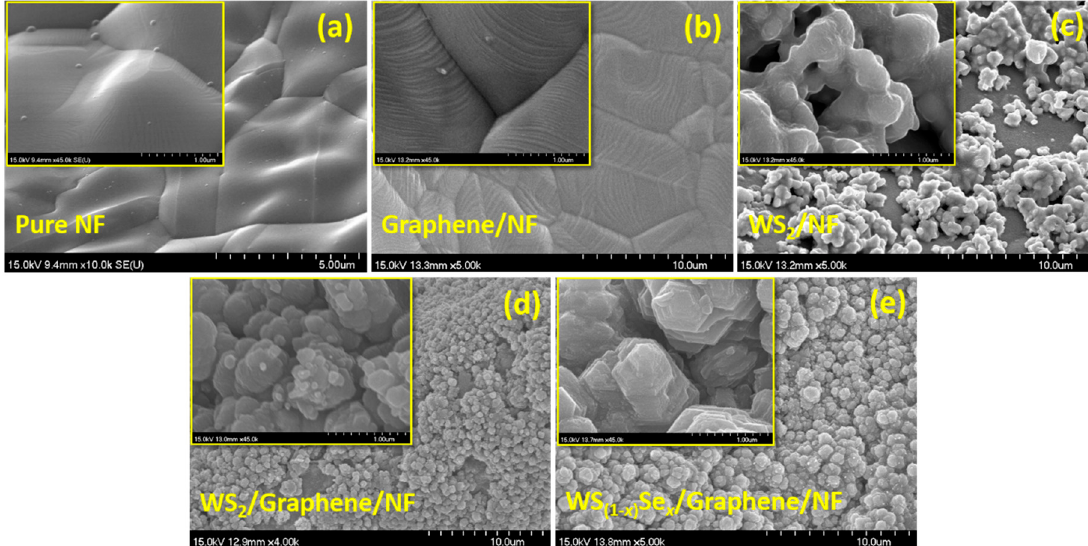
Figure 2. SEM micrographs of ( a ) pure NF; ( b ) graphene/NF; ( c ) WS 2 (45 min)/NF; ( d ) WS 2 /graphene/ NF and ( e ) WS (1 − x ) Se x /graphene/NF.